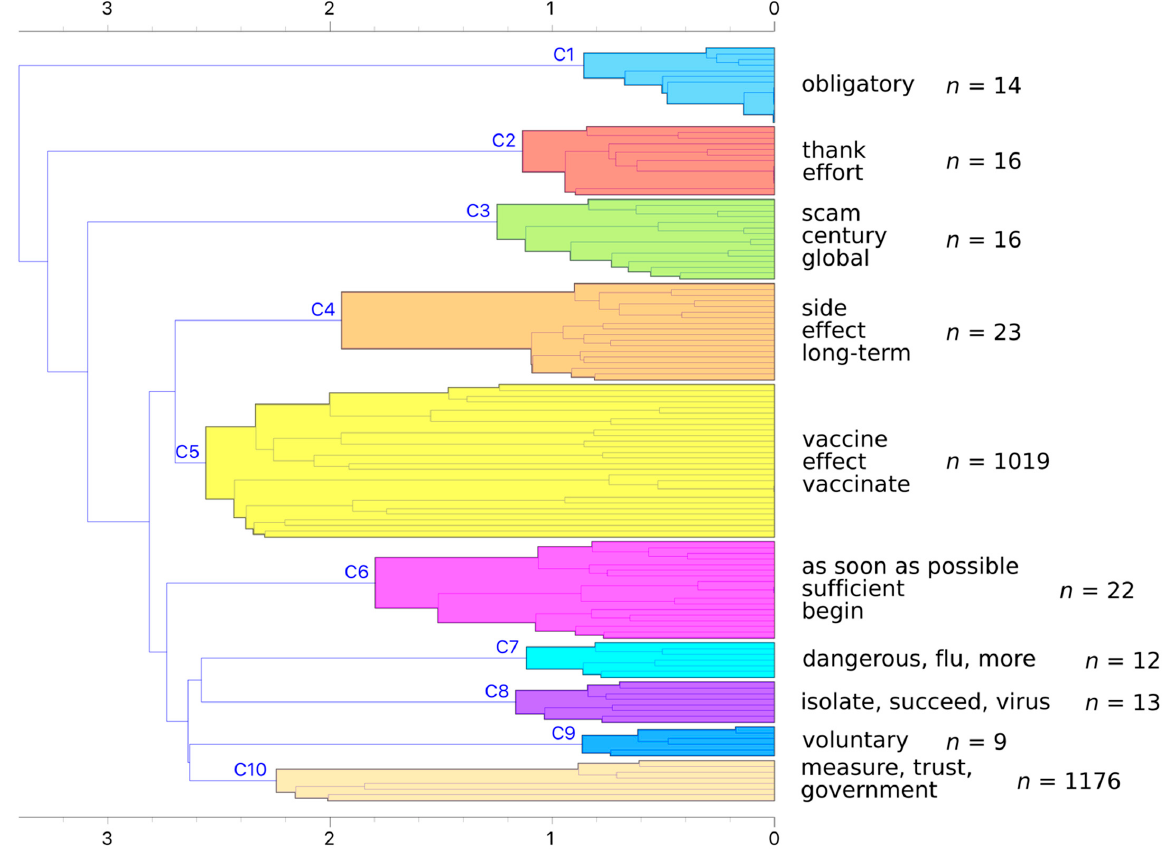
Figure 5. Dendrogram of hierarchical clustering with Ward linkage. The dendrogram is pruned at depth 10 for compact view.